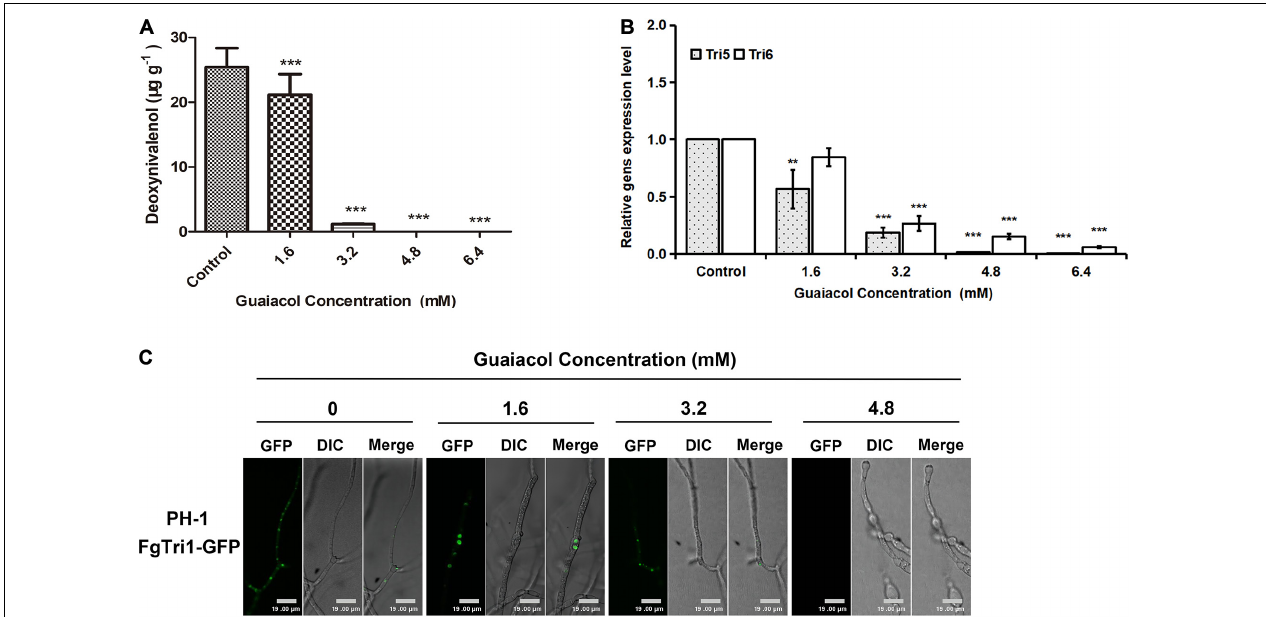
FIGURE 5 | Guaiacol treatment affects DON biosynthesis. (A) Equal amounts of conidia were inoculated into liquid TBI containing guaiacol (0, 1.6, 3.2, 4.8, and 6.4 mM) for 7 days at 28 ◦ C with lights on in dark. DON production was normalized with the dry mycelium collected from the culture. (B) Relative expression of Tri genes ( Tri5 and Tri6 ) involved in DON biosynthesis was determined by qRT-PCR. (C) DON-toxisome was examined in the hyphae harvested from 3 day-old liquid TBI culture with guaiacol (0, 1.6, 3.2, and 4.8 mM ) treatment under fluorescence confocal microscope. Each treatment has three replicates, ** p < 0.01, and *** p < 0.001. Bar = 19 µ m.